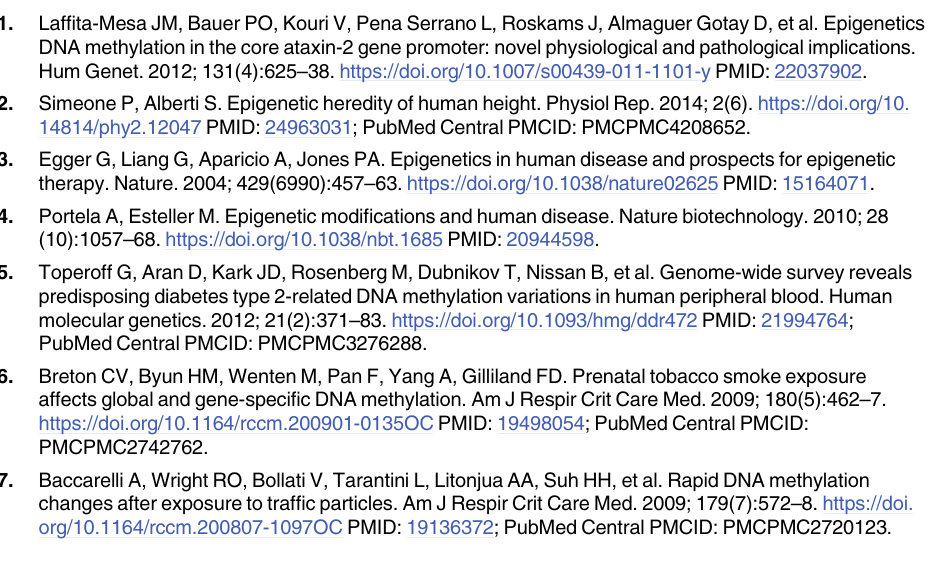
S1 Fig. Quality check for samples using β -values. (A) Hierarchical clustering of β -values for the 13665 conserve probes on the Illumina Infinium MethylationEPIC shows a clear separa- tion between the mouse and human samples. For the mouse samples, DBA/2J and C57BL/6J samples group separately. Mouse sample 1 (M1) is an outlier and has low average signal inten- sity compared to the other mouse samples. (B) Principal component analysis was performed for the 11 mouse samples using β -values for the 13665 conserve probes. A scatter plot of the first two principal components, PC1 and PC2, clearly demonstrate the outlier status of mouse sample 1 (arrow) and this sample was excluded in the differential methylation